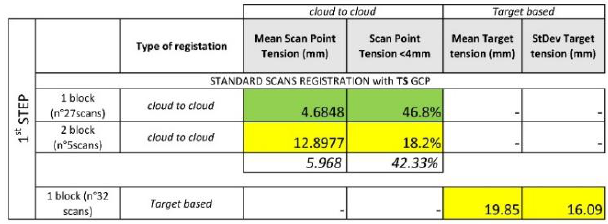
Figure 4. The use of measured targets for the registration phase.